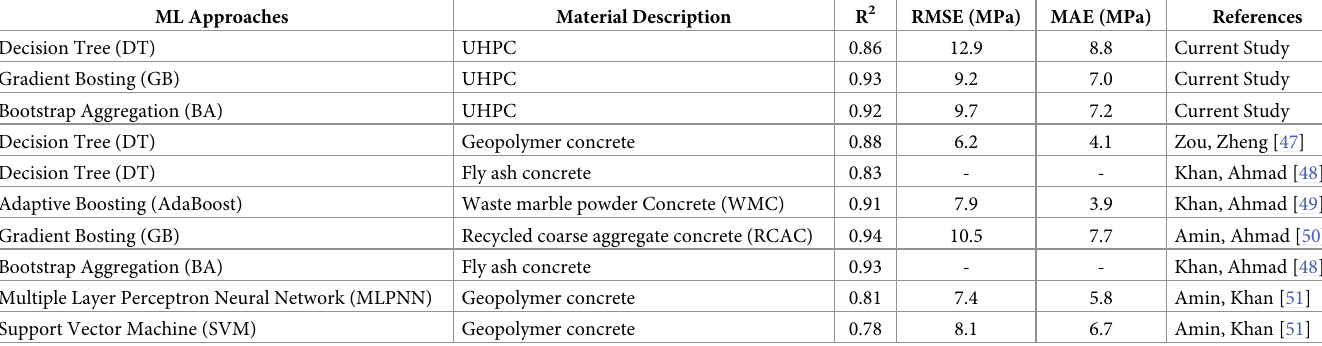
Table 2. Comparison of statistical checks for compressive strength prediction of different concrete types in current study with